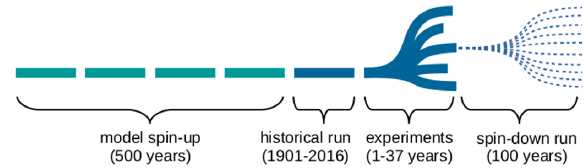
Figure 3. Overview of the general simulation timeline for each scenario. During the experiment period, 1 single year of the me- teorological time series is disturbed, as illustrated by the different branches, and immediately followed by an ensemble of spin-down runs, consisting of average rainfall years only. Each horizontal seg- ment represents a cycle of meteorological forcing